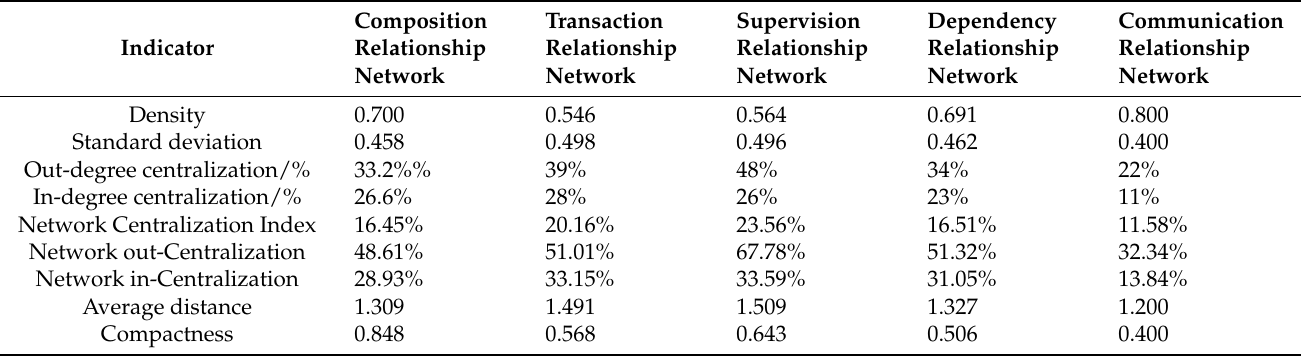
Table 9. Overall network analysis of the relationship network.